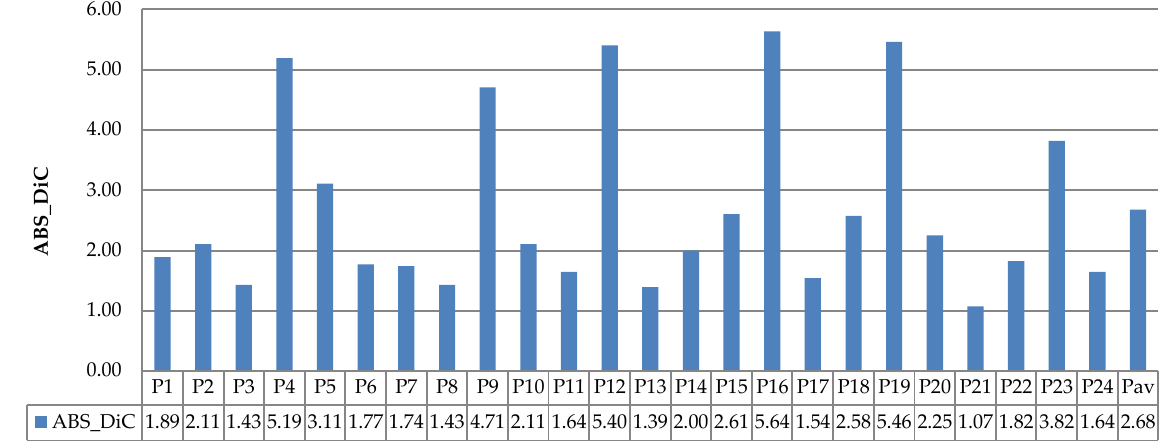
Figure 25. Results of ABS_DiC measurements using Ara2013.